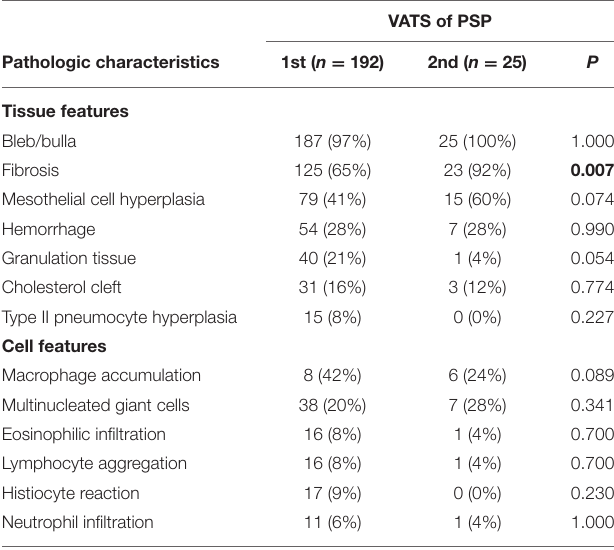
TABLE 2 | Comparison and difference of pathologic characteristics between adolescent PSP having the first and second